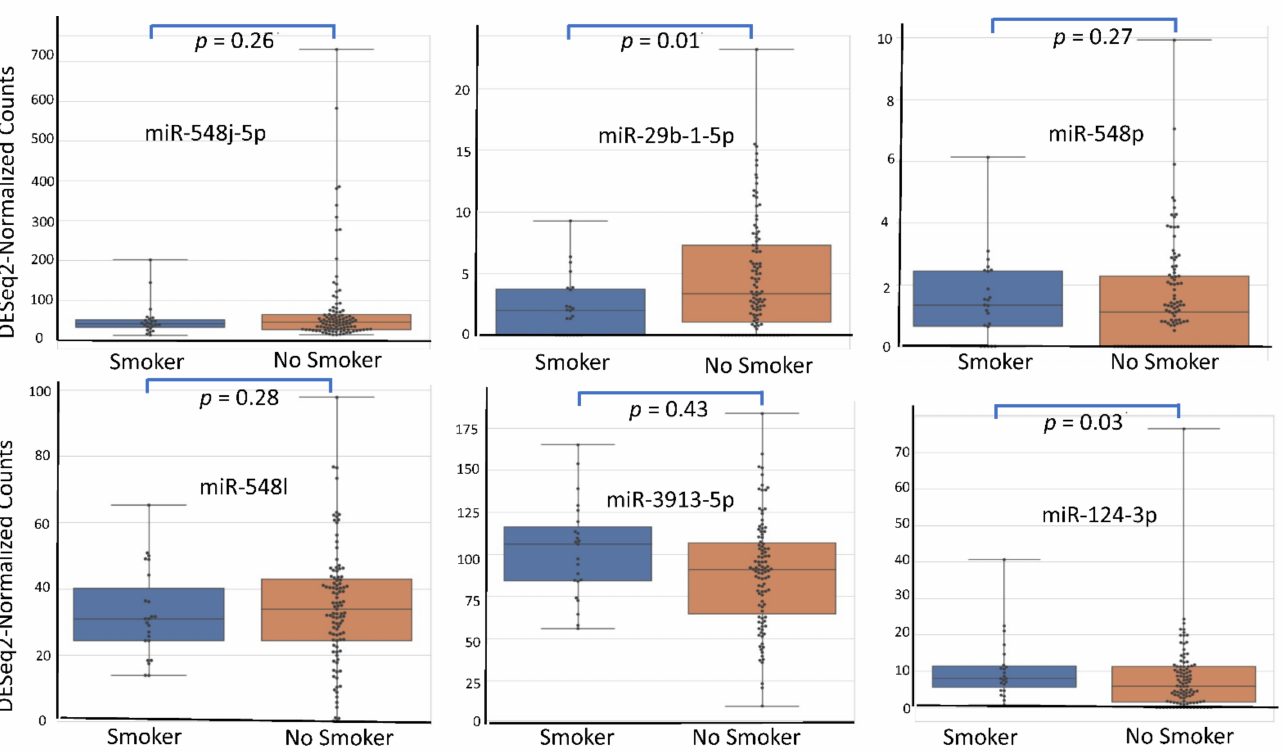
Figure 5. miRNA expression level according to